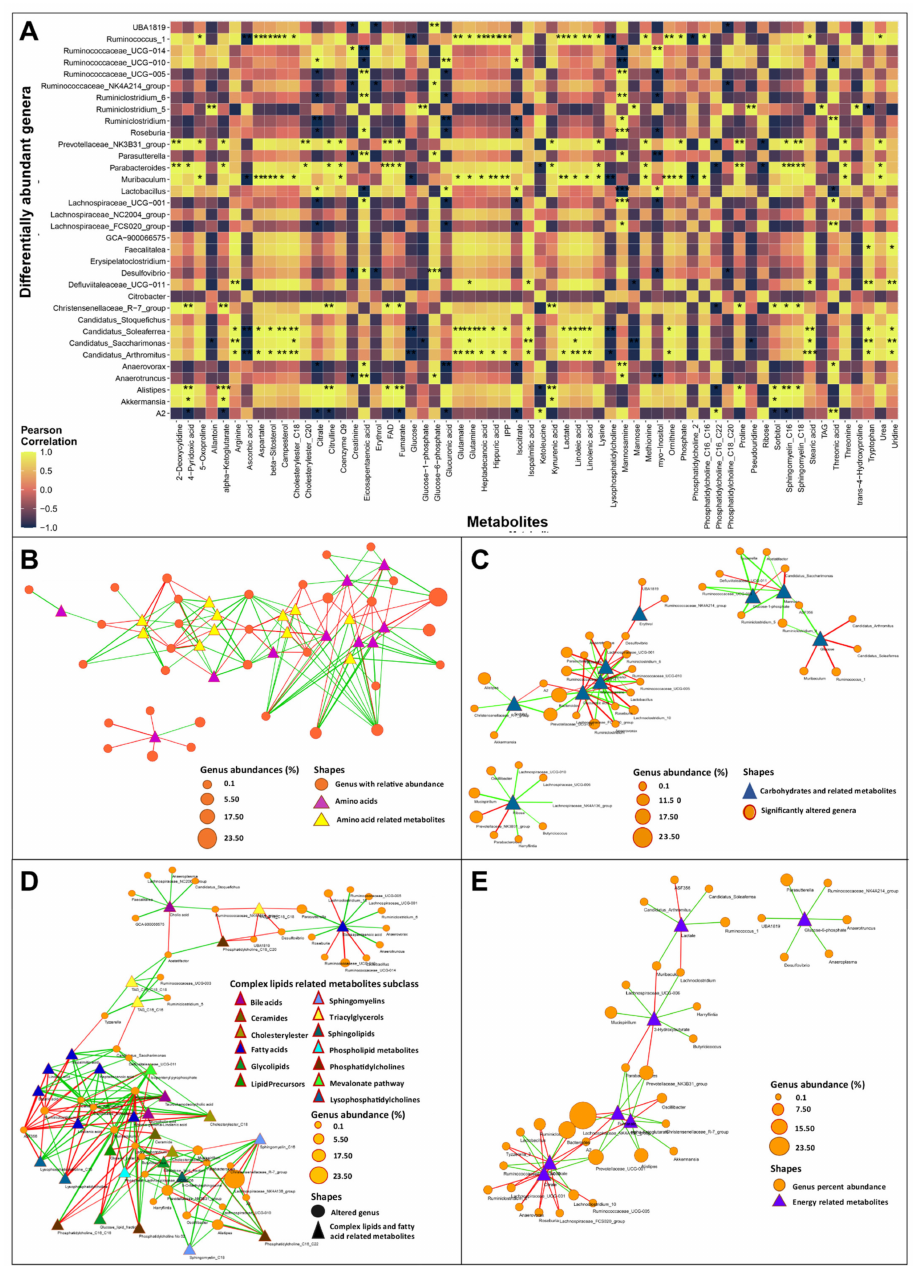
Figure 8. Serum metabolites and gut–microbiome correlation analysis. ( A ) Heatmap showing Pear- son correlations between differentially abundant genera and metabolites with large differences in their ratios in the Sham and TAC samples with significance (* p -values ≤ 0.5, ** p -value ≤ 0.01, *** p -values ≤ 0.001). ( B ) Pearson correlation network in amino-acids-related metabolites and differentially abundant genera in the Sham and TAC samples. ( C ) correlation network between carbohydrate-related metabolites and differentially abundant genera. ( D ) correlation network be- tween complex lipids/fatty acids and differentially abundant genera. ( E ) correlation network between energy-metabolism-related metabolites and differentially abundant genera. ( n values are as follows: Sham = 38, TAC =